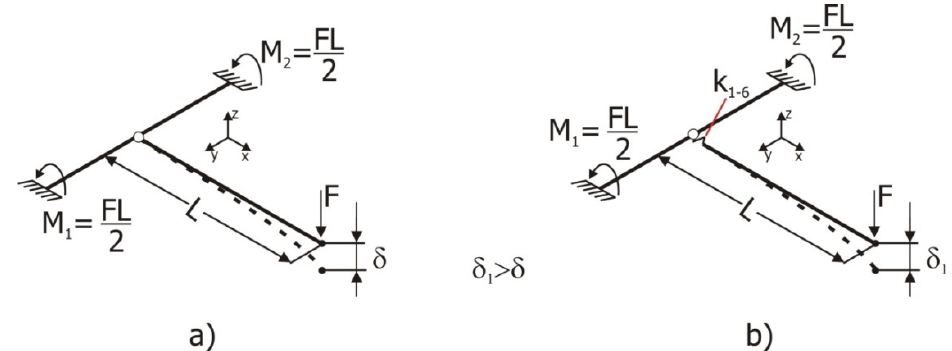
Figure 2. Diagrams comparing the behavior of a standard beam T-junction and the alternative beam T-junction model for the same load state. ( a ) Rigid junction ( b ) flexible junction